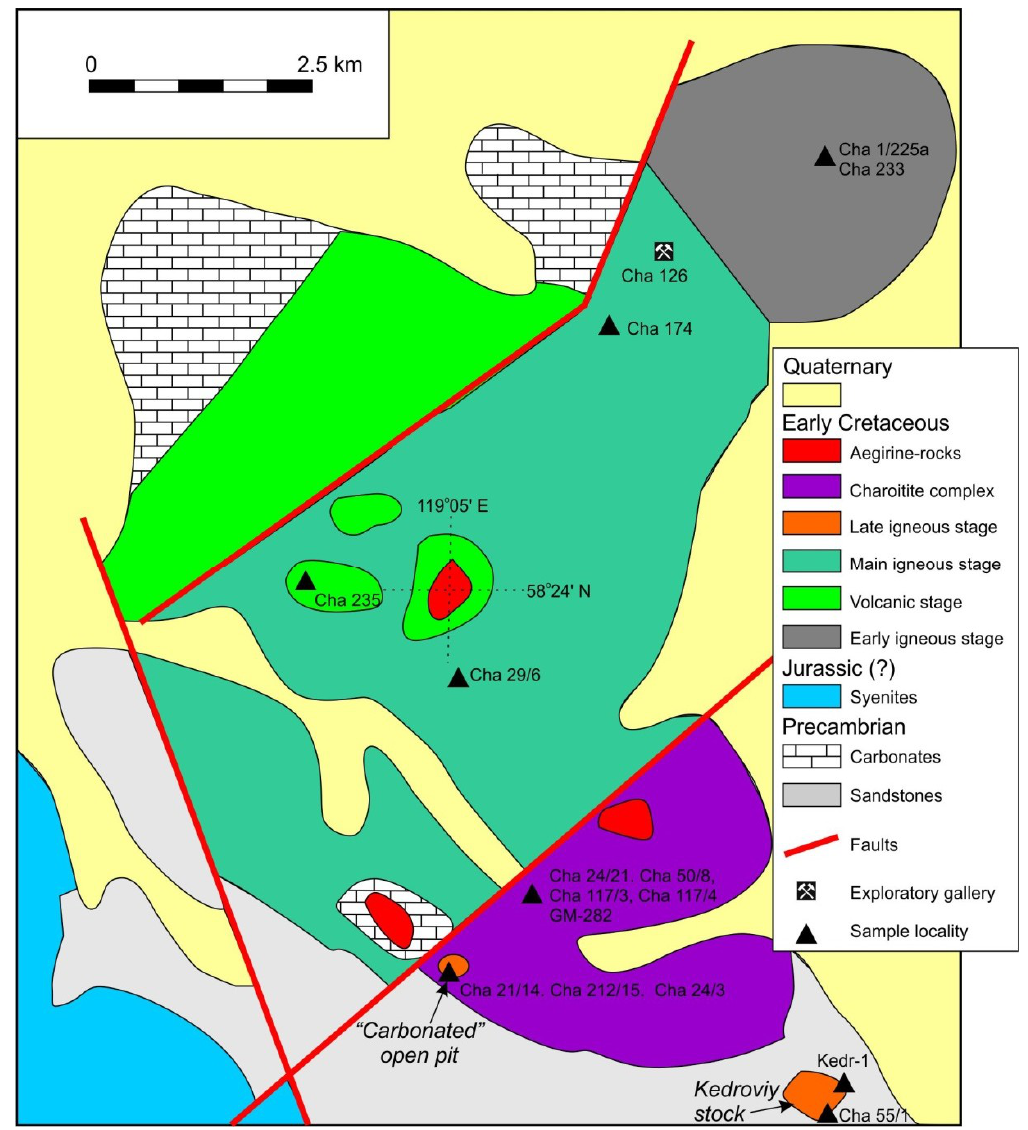
Figure 2. A schematic map of the Malyy Murun massif with the location of the studied samples.